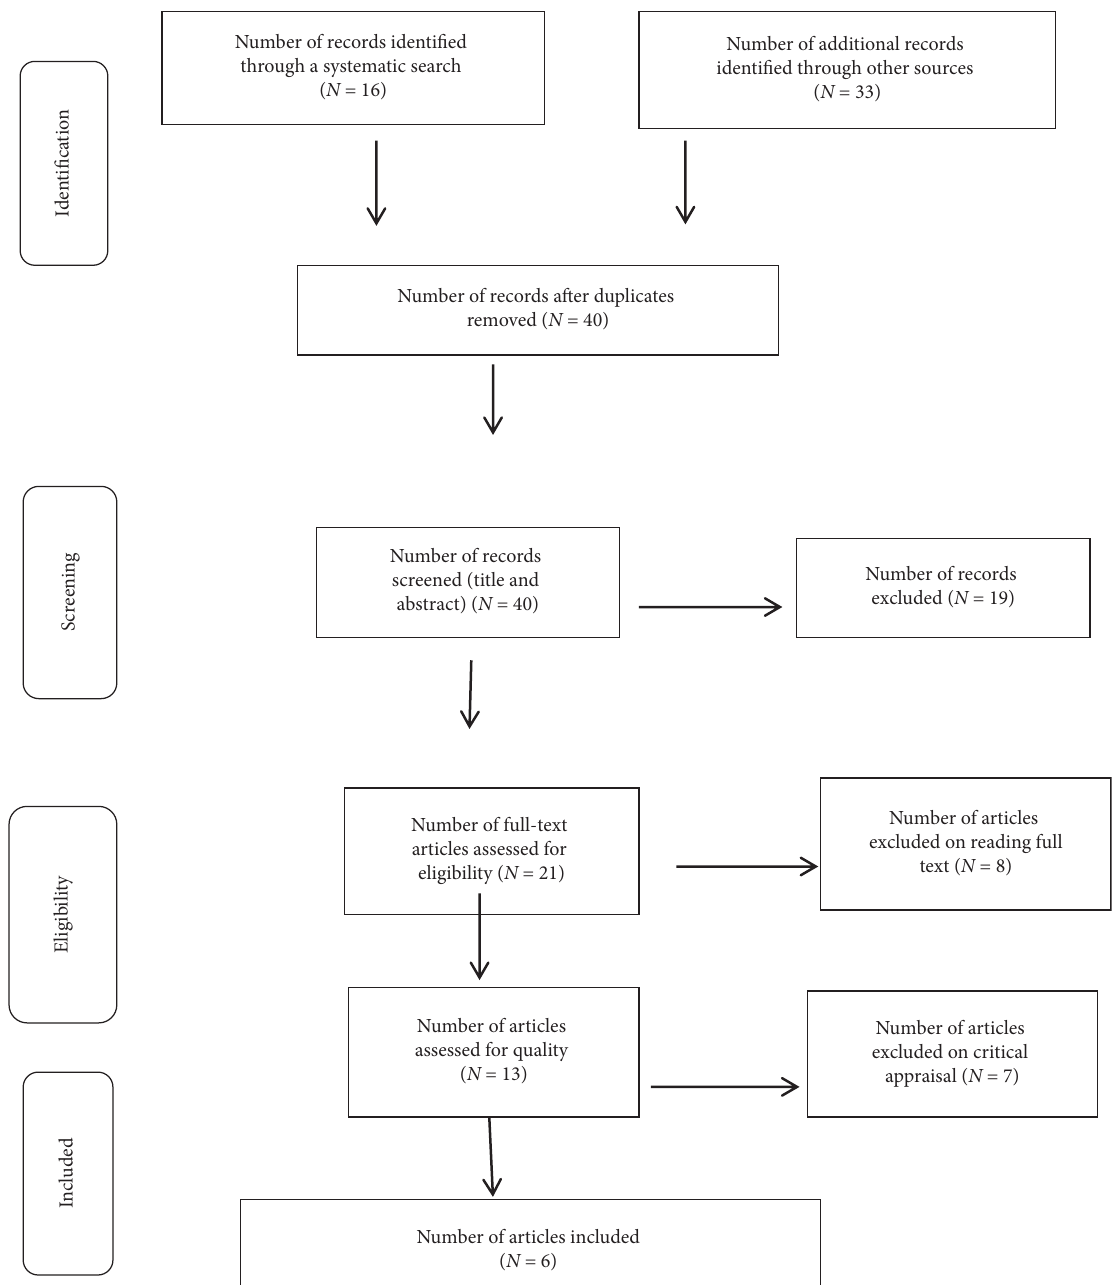
Figure 1: PRISMA flow diagram of IOP changes after insertion of LMA and ETT